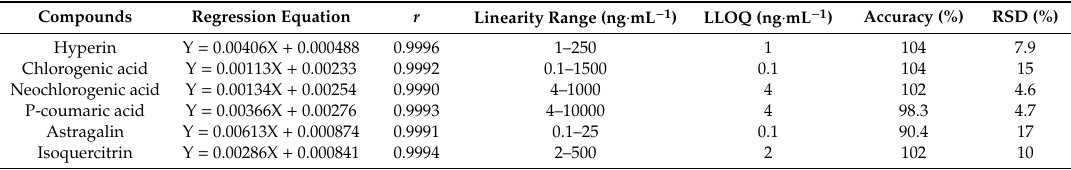
Table 2. Linear range, correlation coe ffi cient( r ), accuracy, and LLOQ ( n = 6) employed in determination of the six compounds in rat